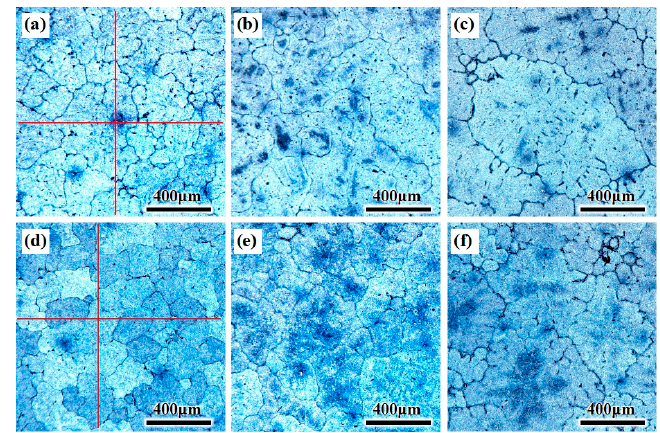
radius, center of CHTI; 2